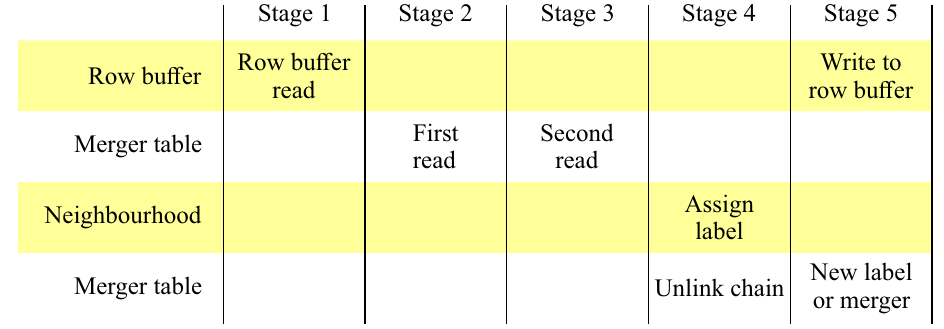
Figure 9. The 5 pipeline stages for processing each input pixel.